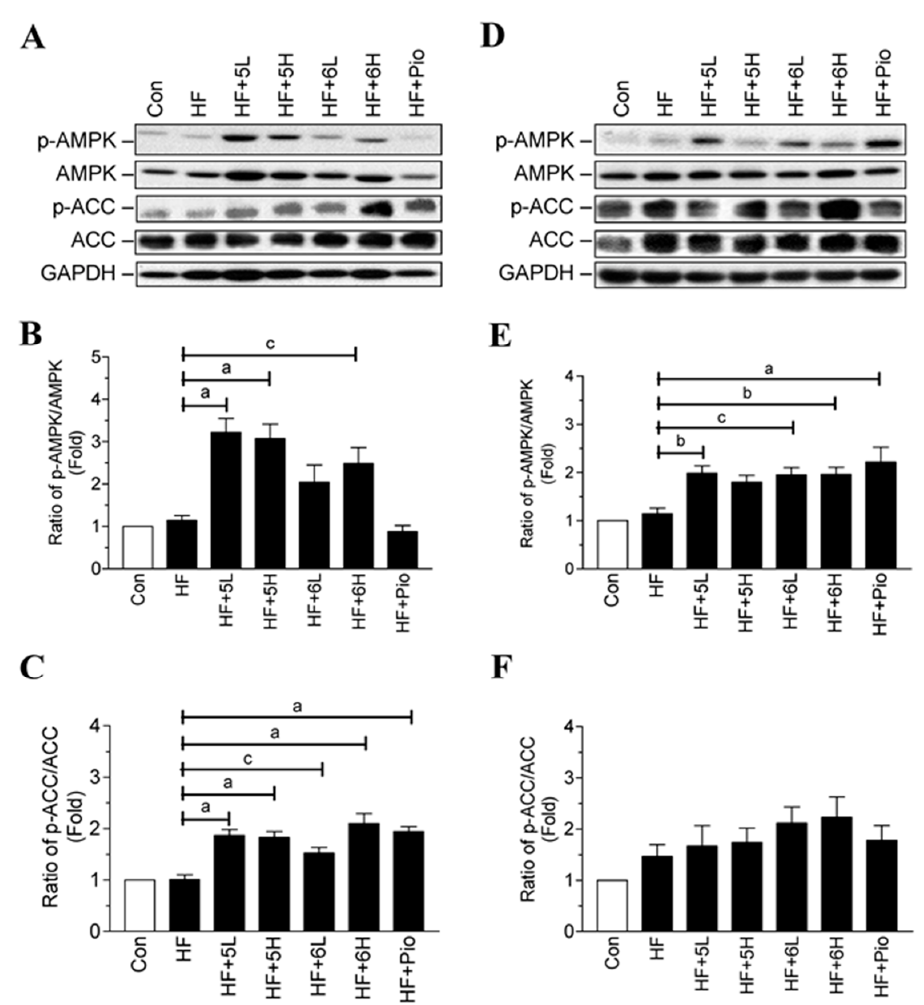
Figure 7. Effects of compounds 5 and 6 on AMPK signaling pathway in the HF-fed mice. ( A ) Proteins from adipose tissues were extracted from the mice, and then phosphorylated and total AMPK and ACC proteins were detected by Western blotting; ( B , C ) the quantitative results for the blots in panel A; ( D ) proteins from skeletal muscles were extracted from the mice, and then phosphorylated and total AMPK and ACC proteins were detected by Western blotting; ( E , F ) the quantitative results for the blots in panel D. Con: normal-diet-fed; HF: high-fat-diet-fed; HF + 5L: high-fat-diet fed with compound 5 (6.75 mg/kg/day); HF + 5H: high-fat-diet fed with compound 5 (33.75 mg/kg/day); HF + 6L: high-fat-diet fed with compound 6 (6.75 mg/kg/day); HF + 6H: high-fat-diet fed with compound 6 (33.75 mg/kg/day); HF + Pio: high-fat-diet fed with pioglitazone (6.75 mg/kg/day). Data are mean ± SD. a : p < 0.001; b : p < 0.01; c : p < 0.05, compared with HF group.